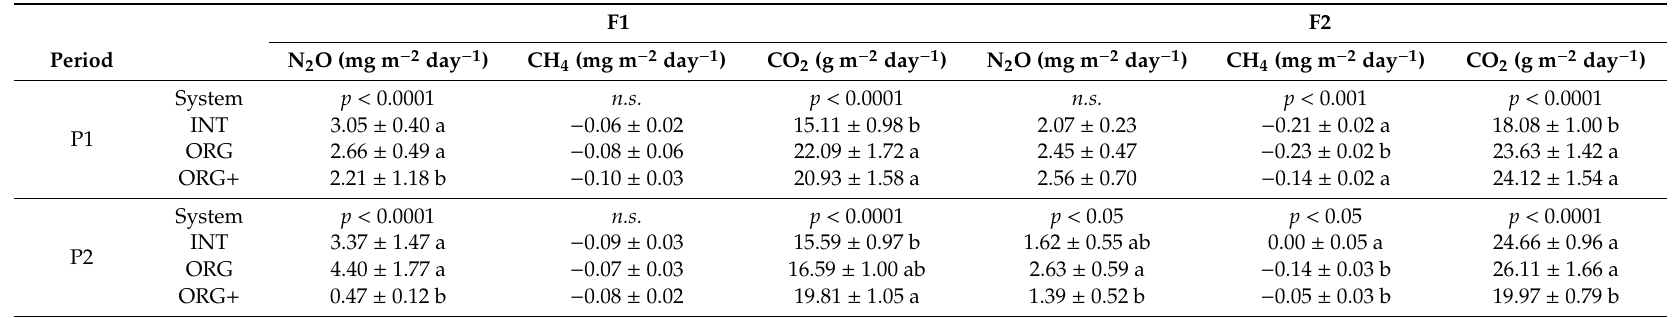
Table 4. E ff ects of the three cropping systems on average daily flux of CO 2 , CH 4 and N 2 O, during the two monitoring periods (P1: January 2015–December 2015; P2: January 2016–July 2016) in Field 1 and Field 2. System levels are INT: Integrated; ORG: Organic; ORG + : Conservation organic. Di ff erent letters represent significant di ff erences between the cropping systems resulting from the post-hoc test. Values are mean ± SE; n =